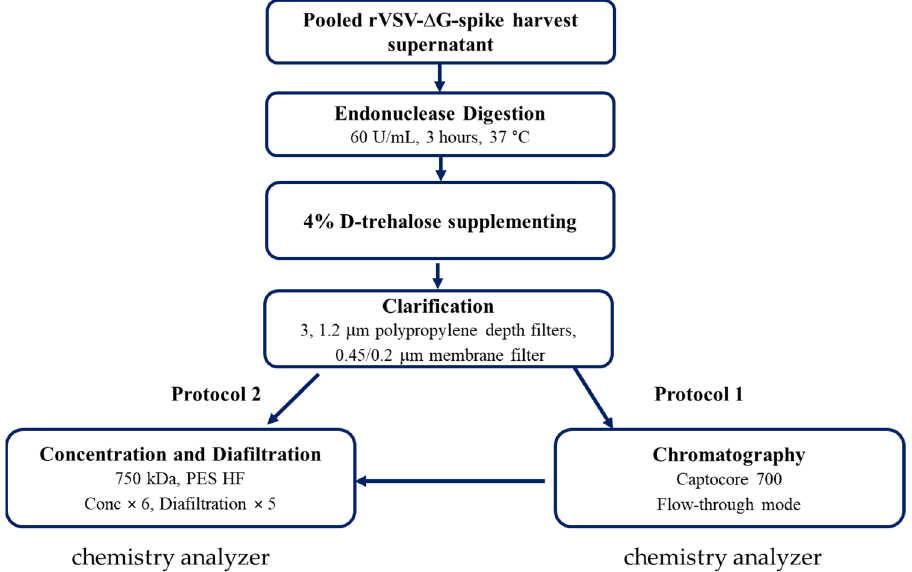
Figure 1. A scheme of the different rVSV- ∆ G-spike purification DSP steps showing the two different purification protocols and the steps that were analyzed with the chemistry analyzer.